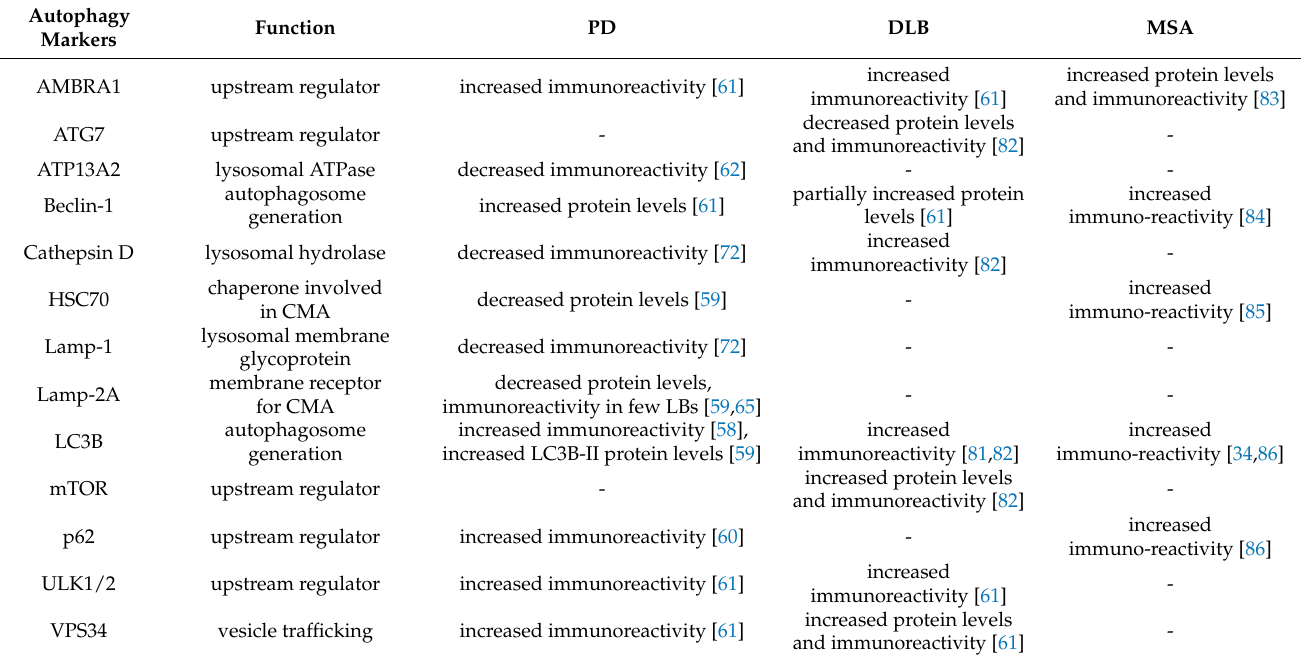
Table 1. Evidence of autophagy involvement found in post-mortem brain tissue of PD, DLB, and MSA patients. Autophagy